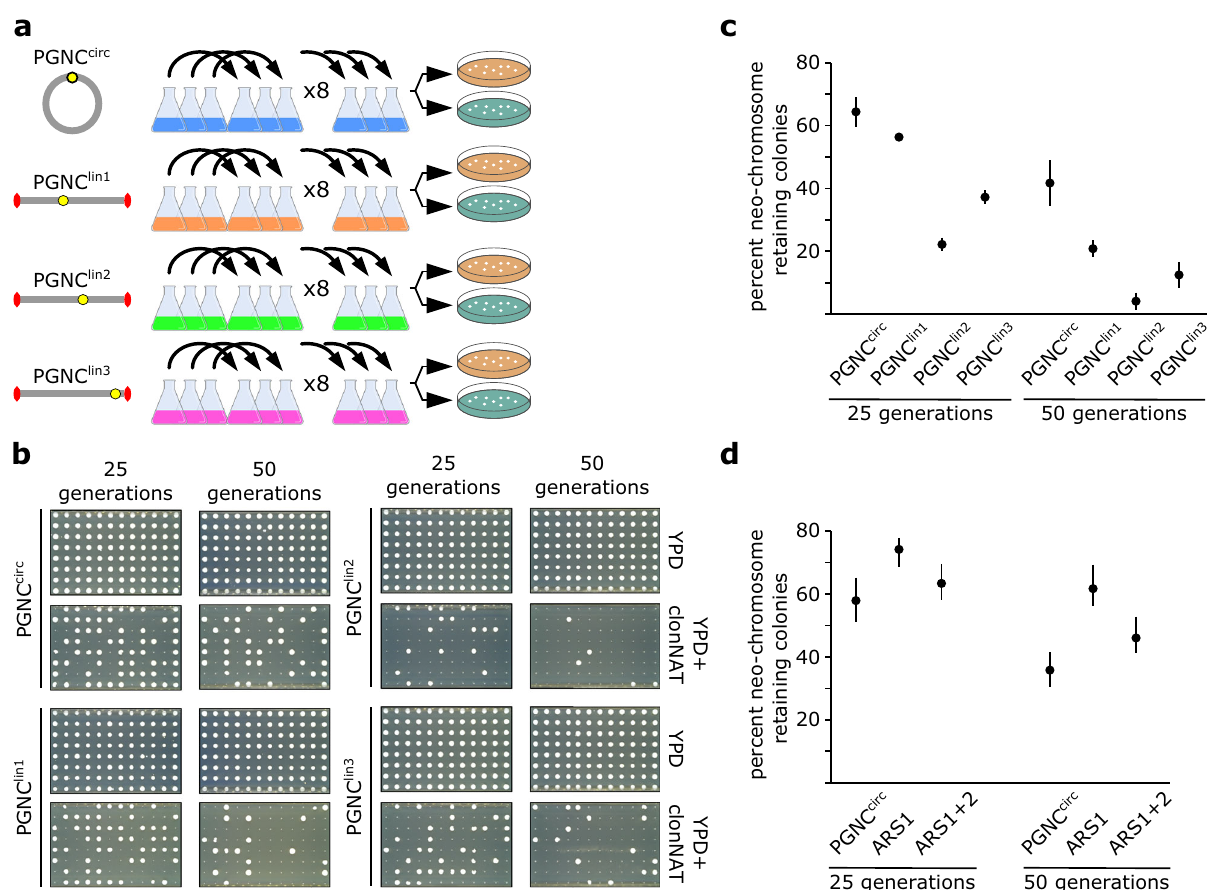
Fig. 2 Mitotic stability of the PGNC in the absence of selection. a Populations were established for each four PGNC variants (PGNC circ , PGNC lin1 , PGNC lin2 and PGNC lin3 ) and serially passaged eight times for ~50 generations of total growth. b Differential plating of 96 colonies for phenotypic assessment of loss of the PGNC element. c Results of passaging experiments (96 colonies per replicate) for each of the PGNC strains after both 25 and 50 generations. d Results of passaging experiments (96 colonies per replicate) for each of the PGNC strains containing additional ARS sequences after both 25 and 50 generations. All graphs are presented as mean values + / − SD, based upon values obtained from three independent biological replicate passaging experiments. Source data are provided as a Source Data fi